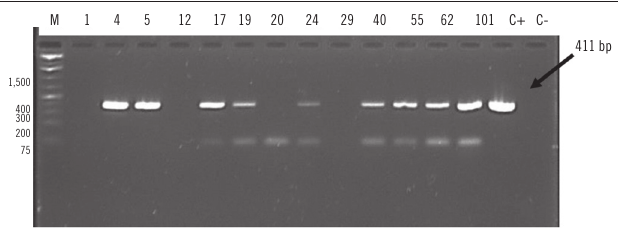
figurE 2 − Photograph of 1.6% agarose gel stained with ethidium bromide as a result of amplification of the UreA gene (H5/H6) with the expected size of 411 bp M: deoxyribonucleic acid (DNA) marker; C+: positive control; C-: negative